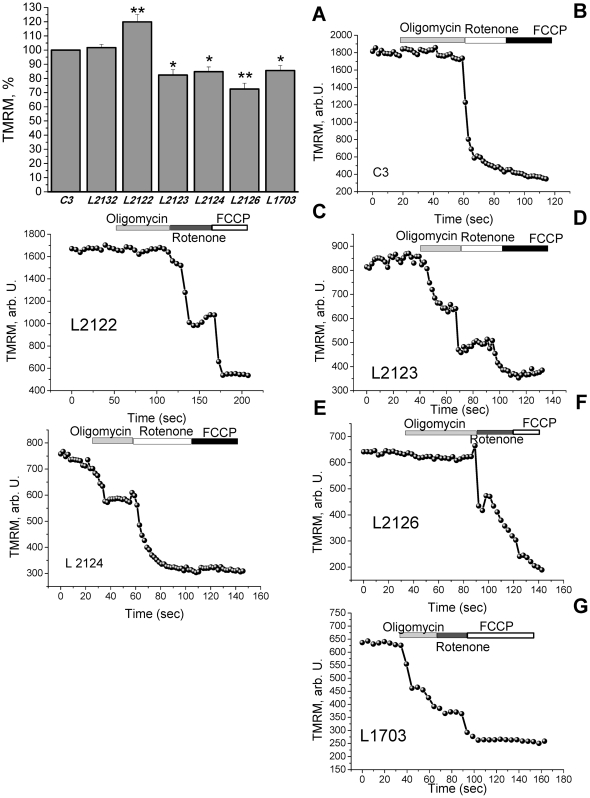
Characteristics of mitochondrial membrane potential (Δψm) in human fibroblasts with PINK1 mutations.A-L2122 fibroblasts exhibited a 20% increase (p<0.001) in TMRM fluorescence (i,e, an increased Δψm) compared to controls. Fibroblasts with PINK1 mutations (L2123, L2124, L2126 amd L1703) showed a significant decrease in Δψm compared to control cells. B–G In control, L2122 and L2126 fibroblasts (B–C, F), oligomycin did not affect Δψm; rotenone induced a partial depolarisation; FCCP induced complete depolarisation. In L2123, L2124 and L1703 fibroblasts (D–E, G), oligomycin caused a mitochondrial depolarisation.